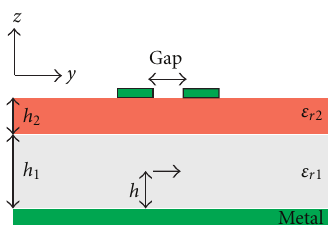
Figure 1: Reference geometry of the structure. The dipolar source is embedded in the substrate, which has permittivity ε r 1 and height h 1 . The superstrate is characterized by permittivity ε r 2 and height h 2 . The nanoparticles are placed on top of the superstrate.